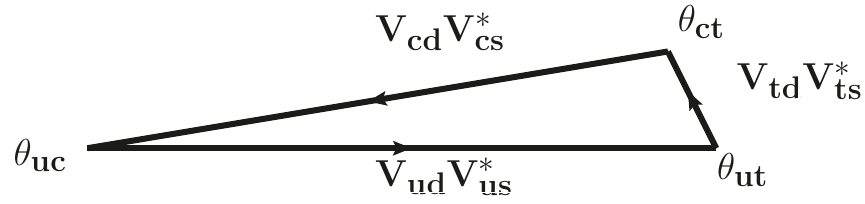
Figure 1 . The “ds” unitarity triangle, see refs. [13, 71]. The plot is not to